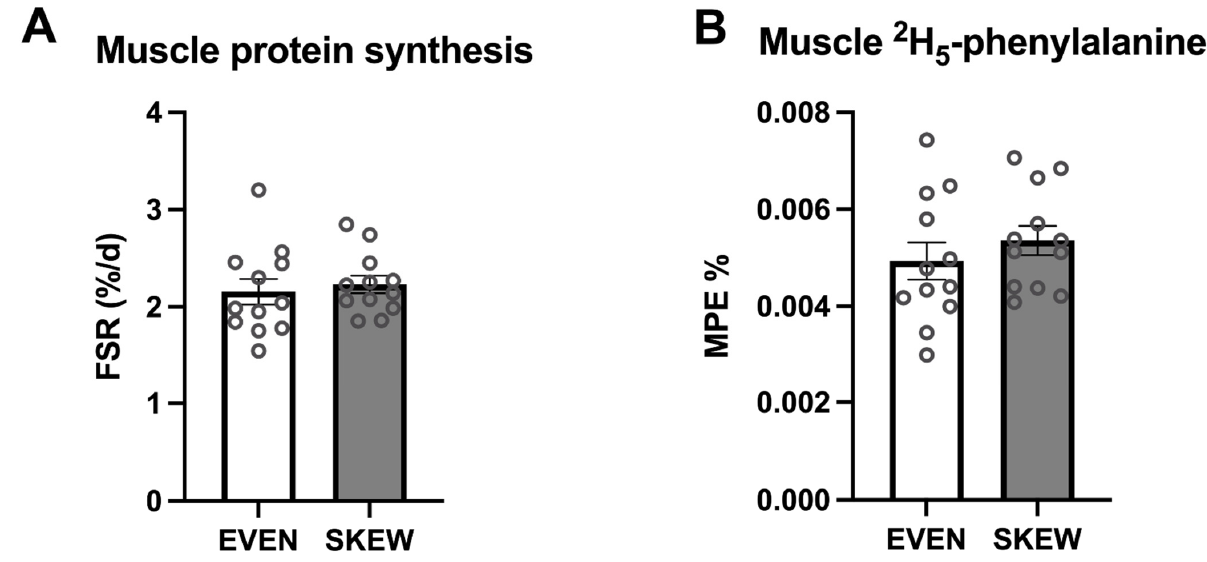
Figure 4. ( A ) Muscle protein FSR and ( B ) muscle 2 H 5 -phenylalanine incorporation. 4A: No signifi- cant difference between the two groups was found for mixed muscle protein FSR ( p = 0.647). 4B: No significant difference between the two groups was found for incorporation of the dietary pro- tein derived 2 H 5 -phenylalanine ( p = 0.387). Data shown as mean ± SEM, with individual data indicated as circles.